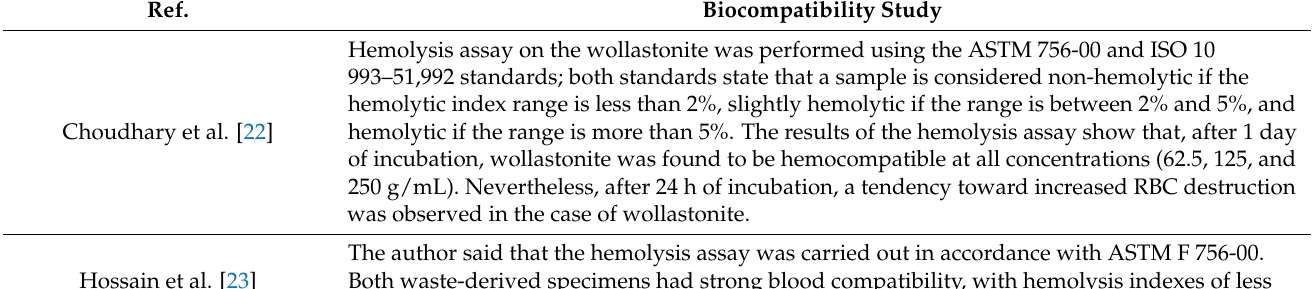
Table 11. Summary of studies on the in vitro biocompatibility of wollastonite derived from RHA and RSA.